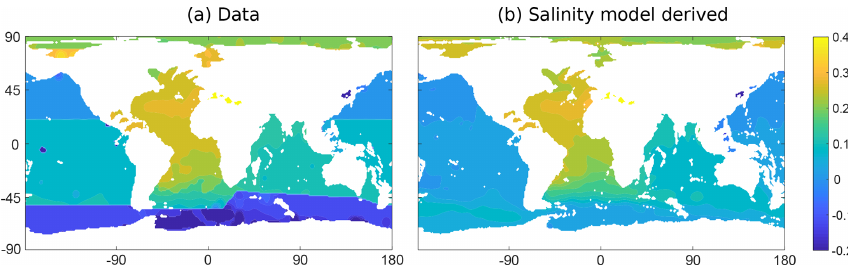
Figure A2. δ 18 O sw data from LeGrande and Schmidt (2006) at 2500m depth (at depths below 2500m, the data set shows little change in δ 18 O sw compared with the values shown) (a) and salinity-derived δ 18 O sw (b) , where salinity data from WOA 2013 (Zweng et al., 2013) are used in the model in Eq. (A1) (all in ‰ VSMOW ).